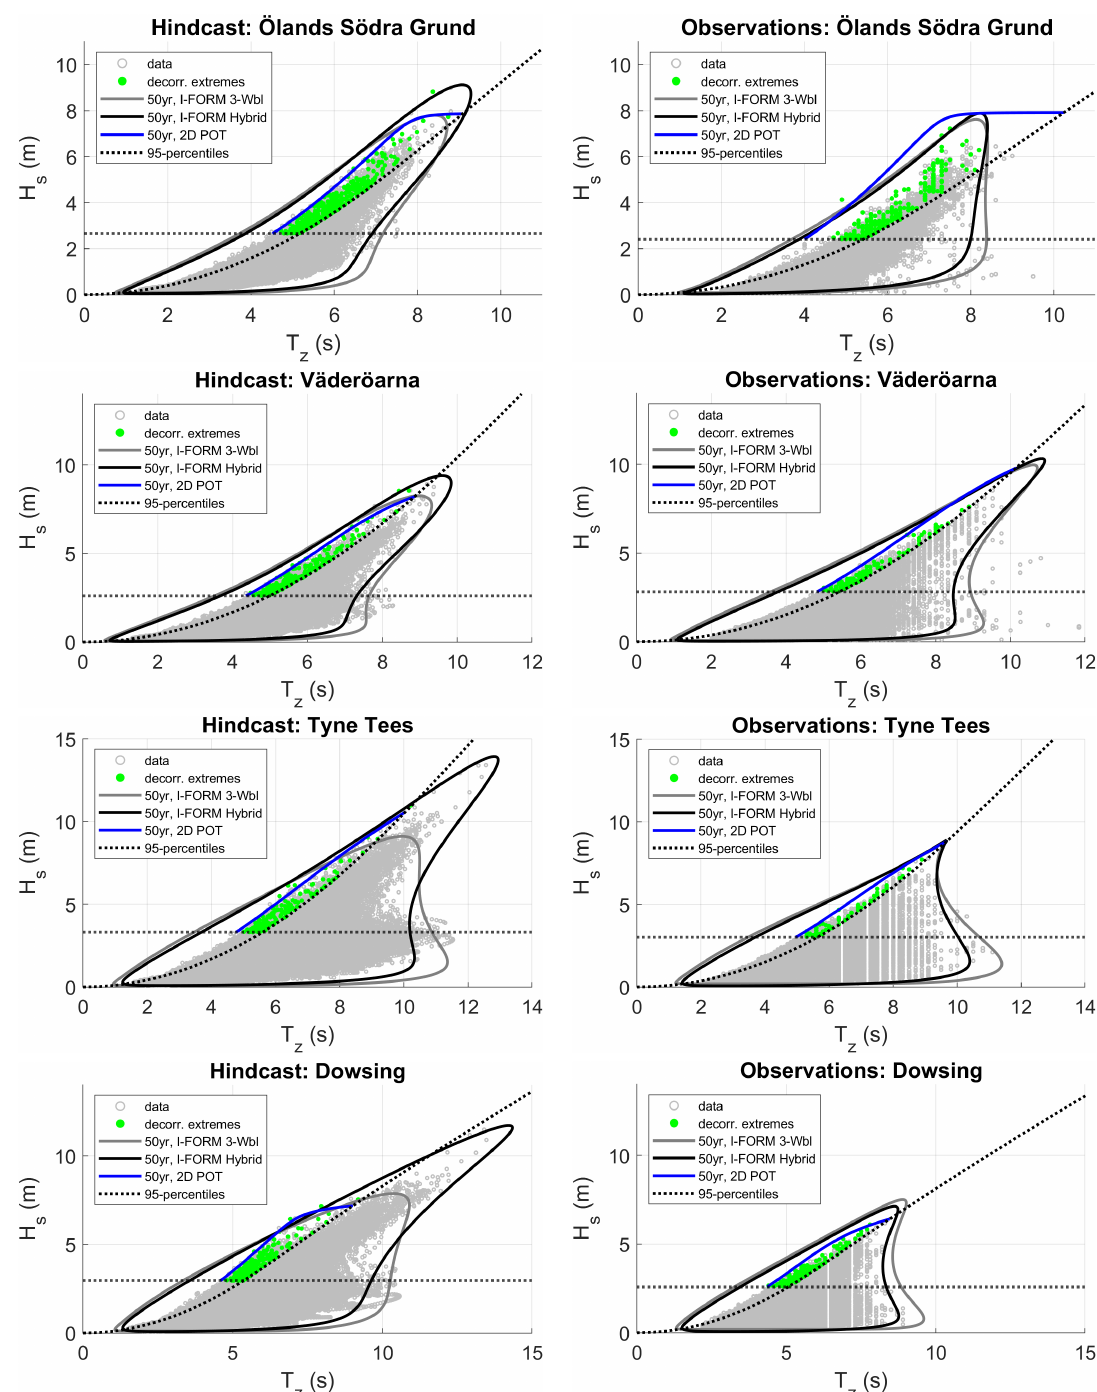
Figure 10. Comparing 50-year environmental contours for three different methods: (1) I-FORM with 3-parameter Weibull = 0.2 (gray solid line); (2) I-FORM with a hybrid fit for H s , without inflation (black solid fit for H s , with β inflated using α 2 0 line); and (3) 2D Peaks-Over-Threshold (blue solid line). The threshold percentiles for both H s and the steepness are also shown (black dotted